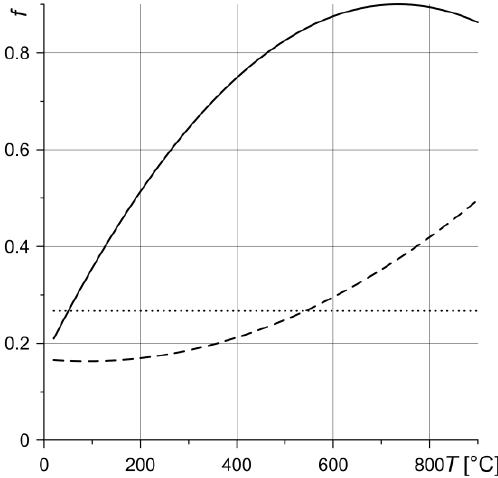
Figure 4. Dependence of the coefficient of friction of the single-name friction pair CFCM-5 on the maximum temperature T max : solid line—variant 1, dashed line—variant 2, dotted line—variant 3.